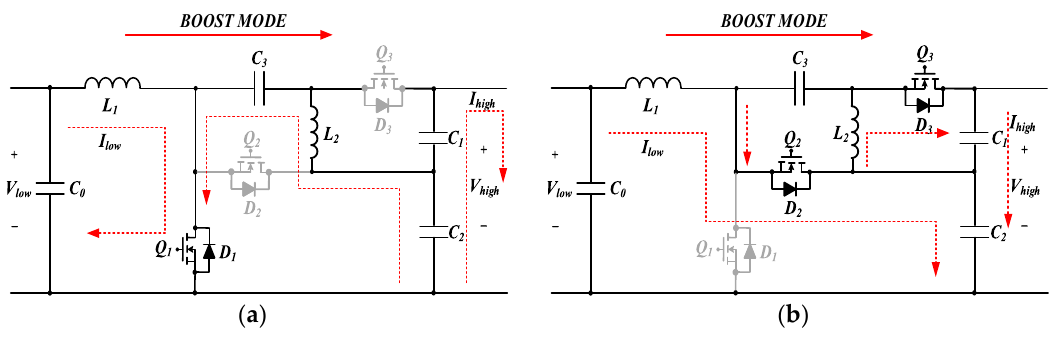
Figure 5. Topological states of the converter I in boost mode. ( a ) [ t 0 –t 1 ]. ( b ) [ t 1 –t 2 ].